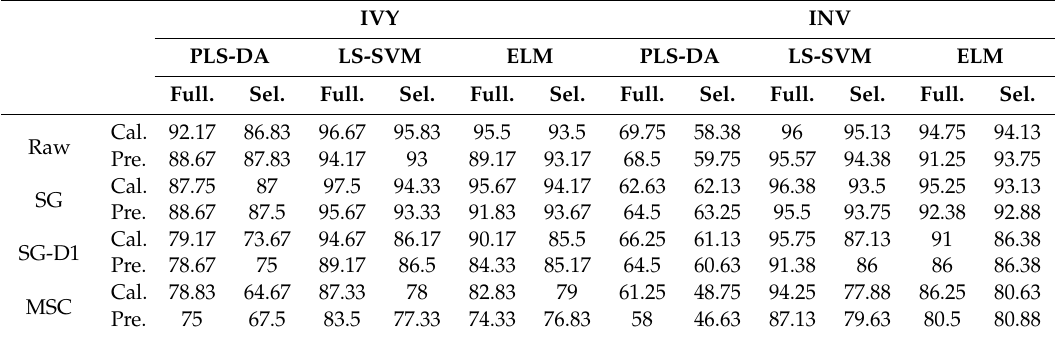
Figure 5. The prediction results of classification models for identifying ( a ) seed vitality of three di ff erent years and ( b ) non-viable seeds from viable seeds of three di ff erent seeds. Table 2. The results of classification models established by full and selected wavelengths with di ff erent preprocessing